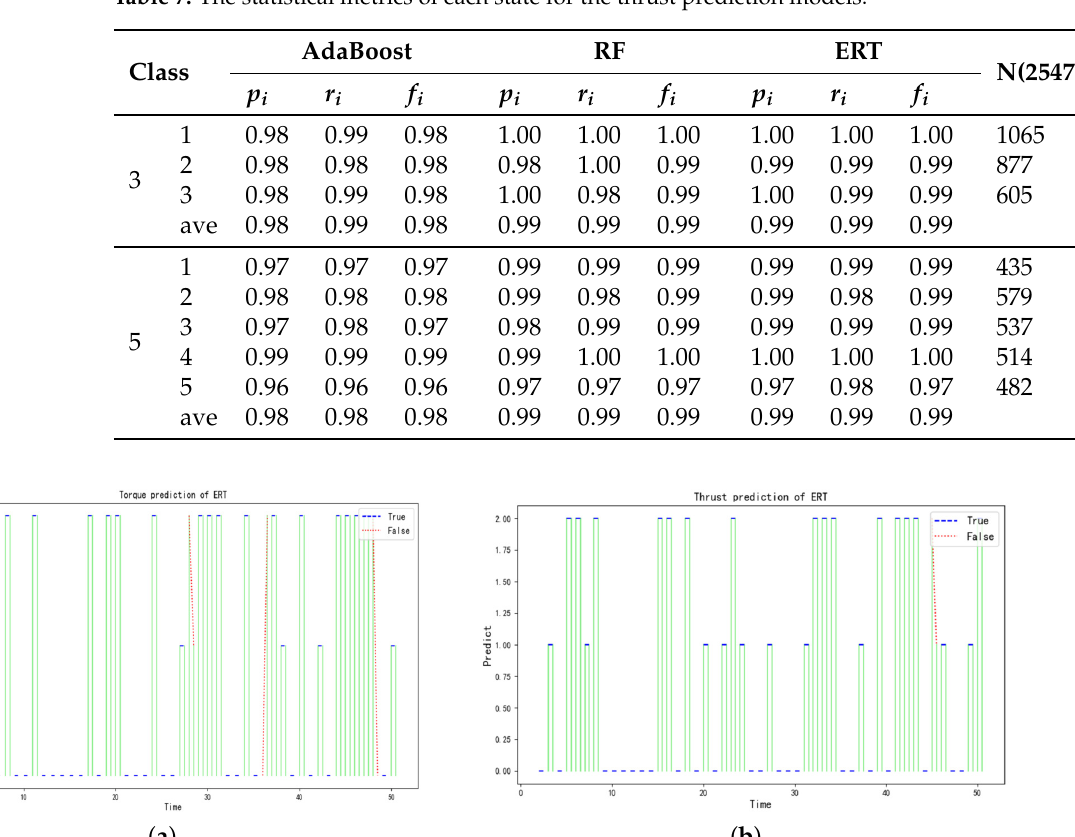
Table 7. The statistical metrics of each state for the thrust prediction models.